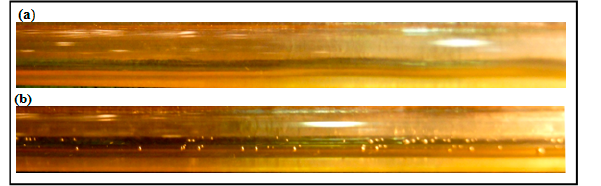
Figure 4. ( a ) Stratified Wavy flow without DRP (V sl =0.1 m/s, V sg =0.41 m/s); ( b ) Stratified Wavy flow with 40 ppm DRP.